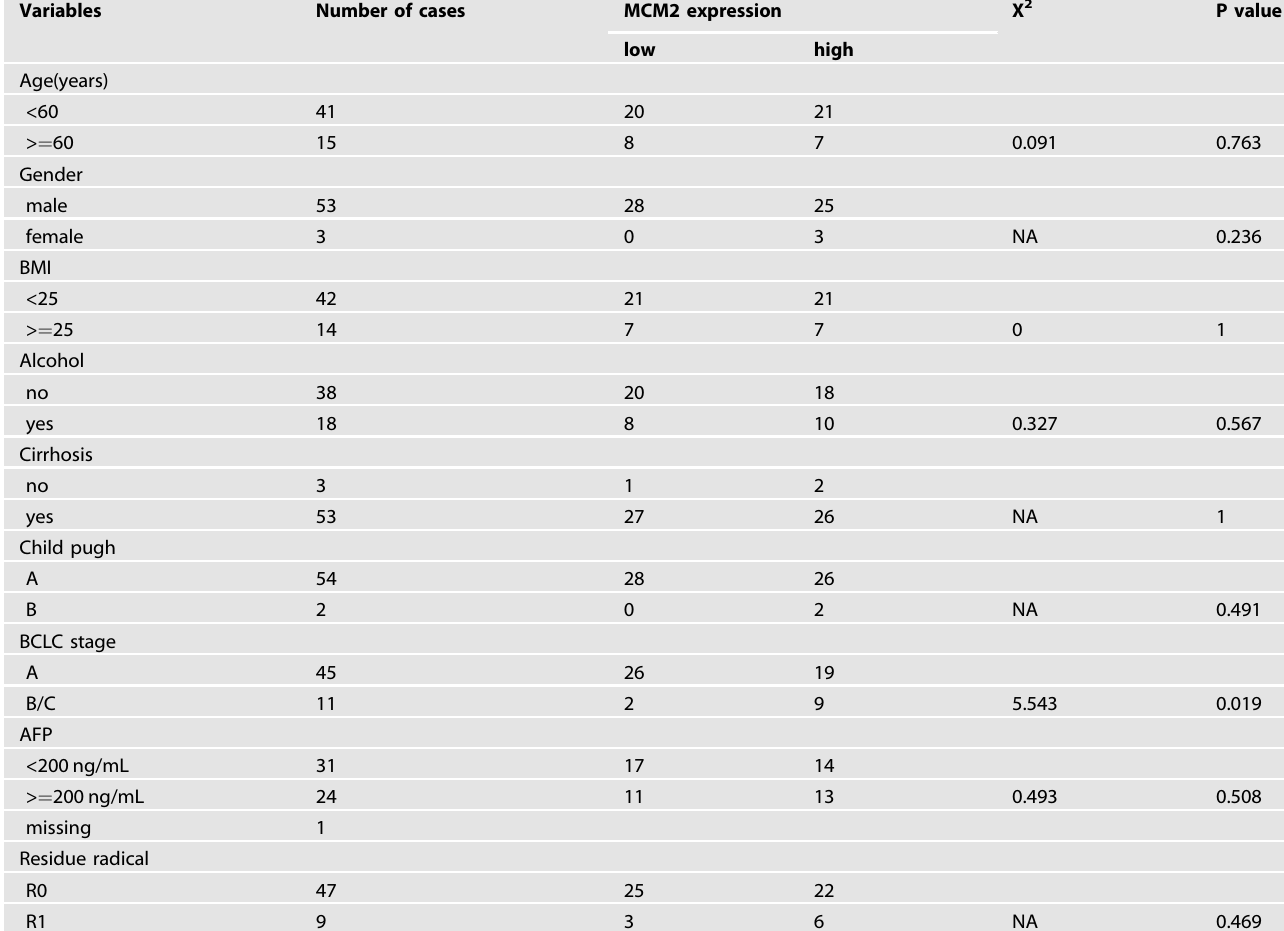
Table 1. Basic information of 56 HCC patients from the fi rst af fi liated hospital of GXMU.